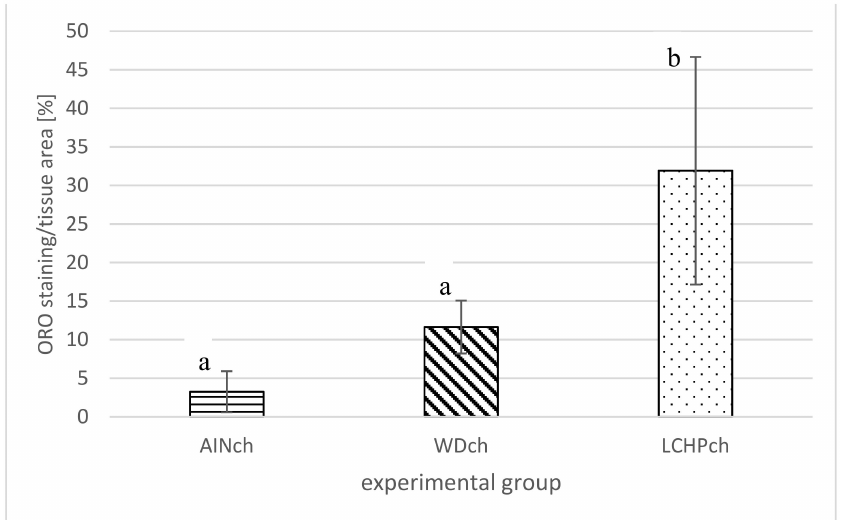
Figure 6. ORO staining/tissue area (%) of liver of rats after 8 weeks of feeding: AIN ch , WD ch or LCHP ch diets, enriched with 1% cholesterol. The means marked with letters a and b are significantly different ( p <